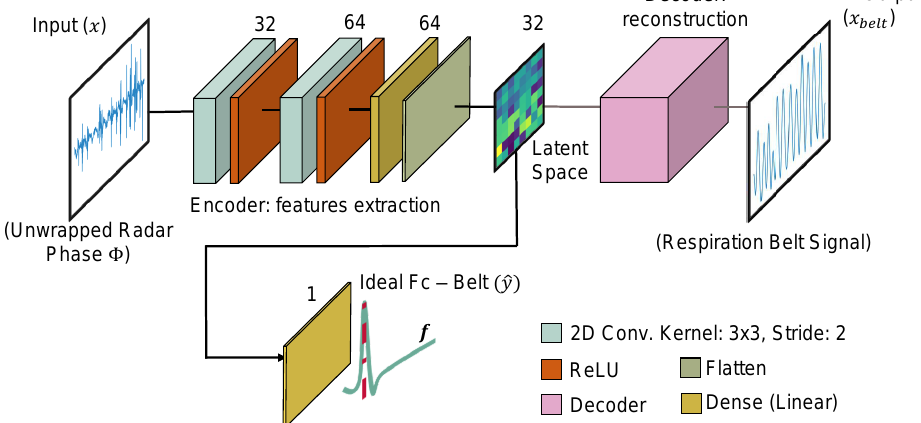
Figure 12. Chosen C-VAE topology. The latent space representation is constrained by both the reconstruction of x with respect to the x belt reference and the ideal Fc of breathing y . The decoder layers are an up-sampled mirror version of the encoder layers.